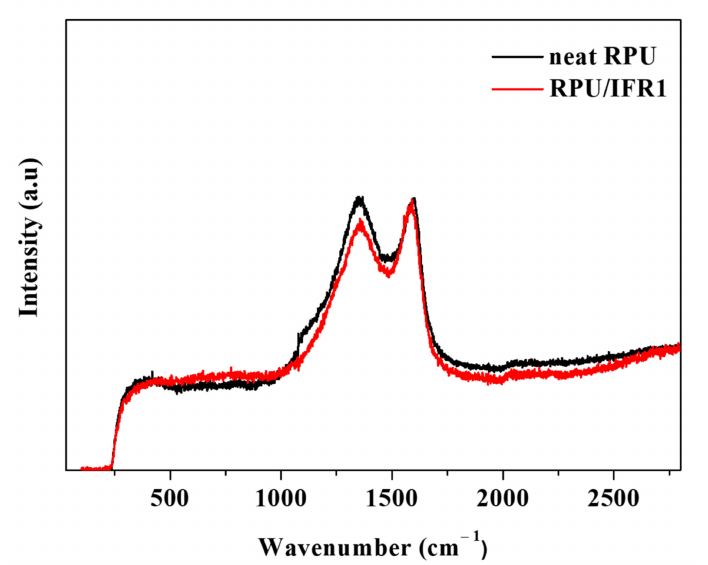
Figure 5. SEM images ( a , c ) and corresponding EDX spectra ( b , d ) of the char residues of the neat RPU ( a , b ) and RPU/IFR1 foam samples ( c , d ).